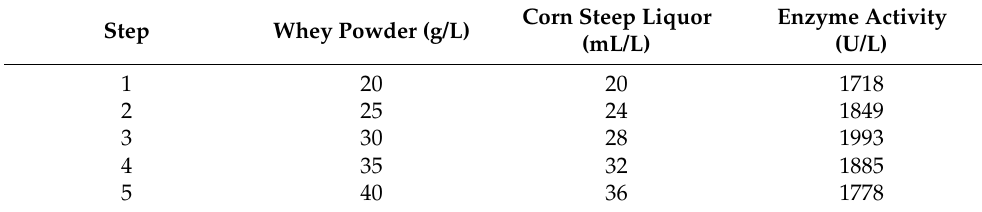
Table 2. Experimental design and results of the steepest